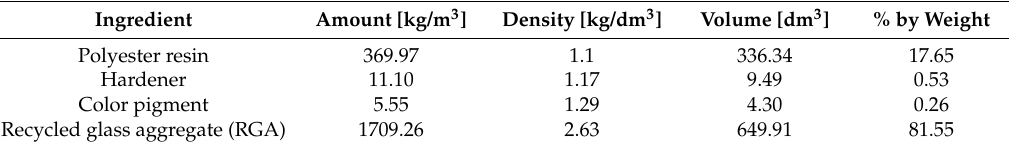
Table 3. Composition of the Polymer Concrete Mix: